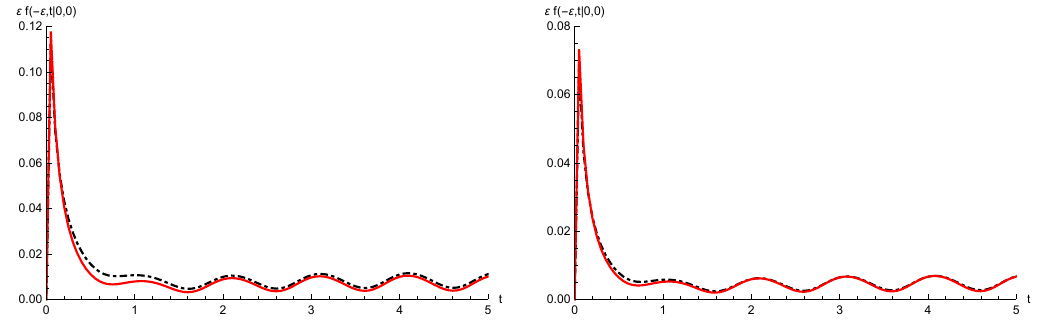
Figure 6. For (cid:98) λ = 2.0, (cid:98) µ = 1.0, ω 2 = 0.2, the function ε f ( 0, t | 0,0 ) (red curve) is shown with the probability p 0,0 ( t | 0 ) (black dashed curve) for ε = 0.05 (left) and ε = 0.025 (right). The parameters λ and µ are shown in Example 2, according to (45).